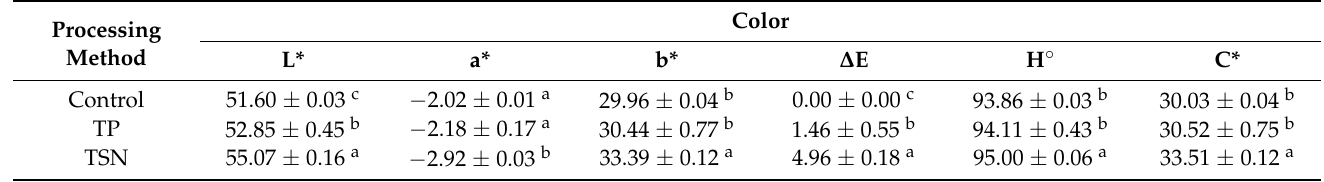
Table 1. The color parameters of control, TSN, and TP treatment